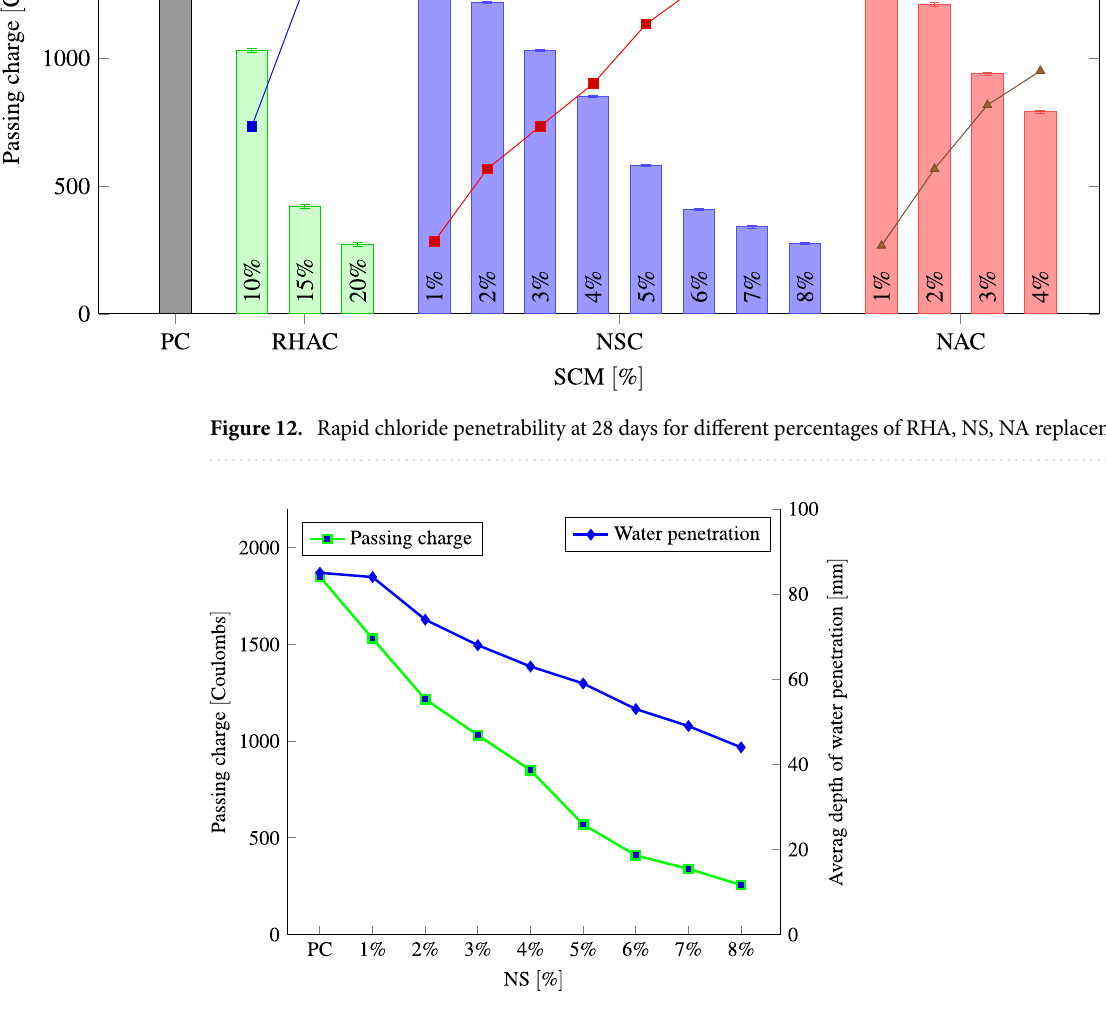
Figure 13. Relationship between the chloride penetrability and water penetration after 28 days for different percentages of